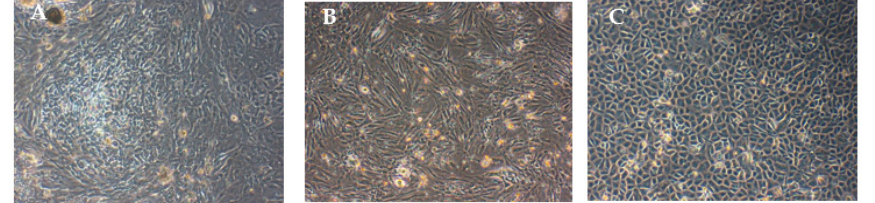
Figure 1. Monolayer cells cultured in 6-well plate: ( A ) Co-culture of respiratory epithelial cells (RECs), and fibroblasts, ( B ) fibroblasts, and ( C ) RECs. The co-cultured cells became confluent in a week’s time and fibroblasts were separated by differential trypsinization before seeding into a new flask.